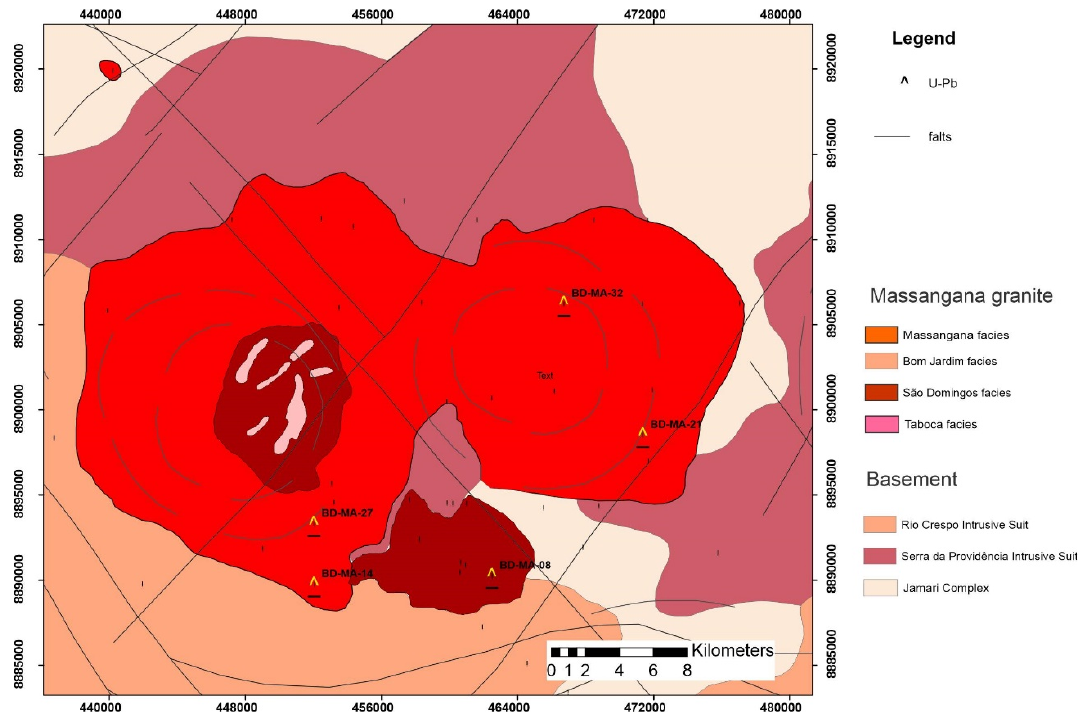
Figure 4. Geological map of the Massangana Massif showing sampled points.